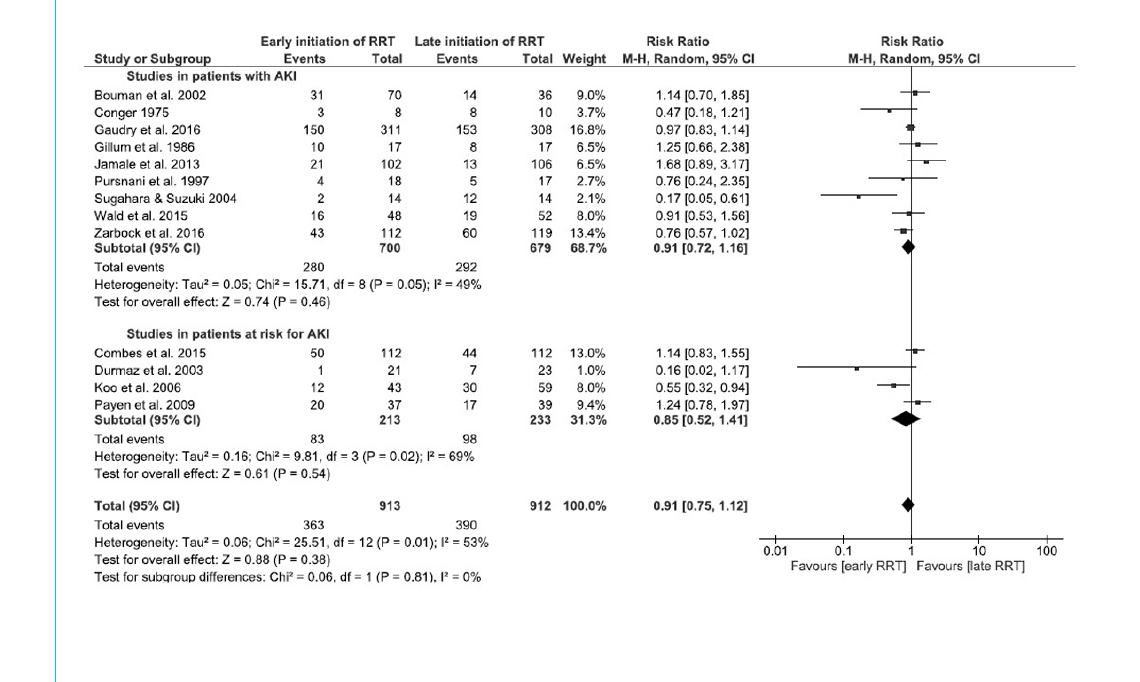
Figure 3: Forest plot demonstrating the impact of early renal replacement therapy on in-hospital or 60-day mortality compared with late renal replacement therapy in patients with acute kidney injury (AKI) (9 studies), at risk for AKI (4 studies), and in all 13 studies. Data are presented as risk ratios with 95% confidence intervals. A random-effects model was